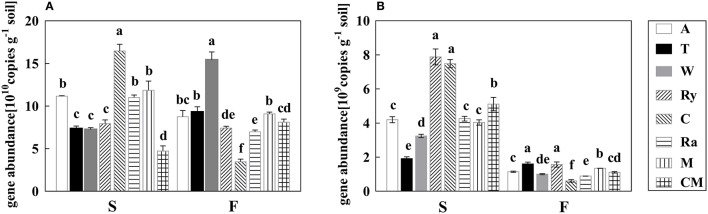
The abundances of bacterial 16S rRNA gene (A) and fungal ITS gene (B) under different treatments in the spring (S) and fall (F) cropping seasons. Data with different letters in each column indicate significantly different between treatments at 0.05 level.